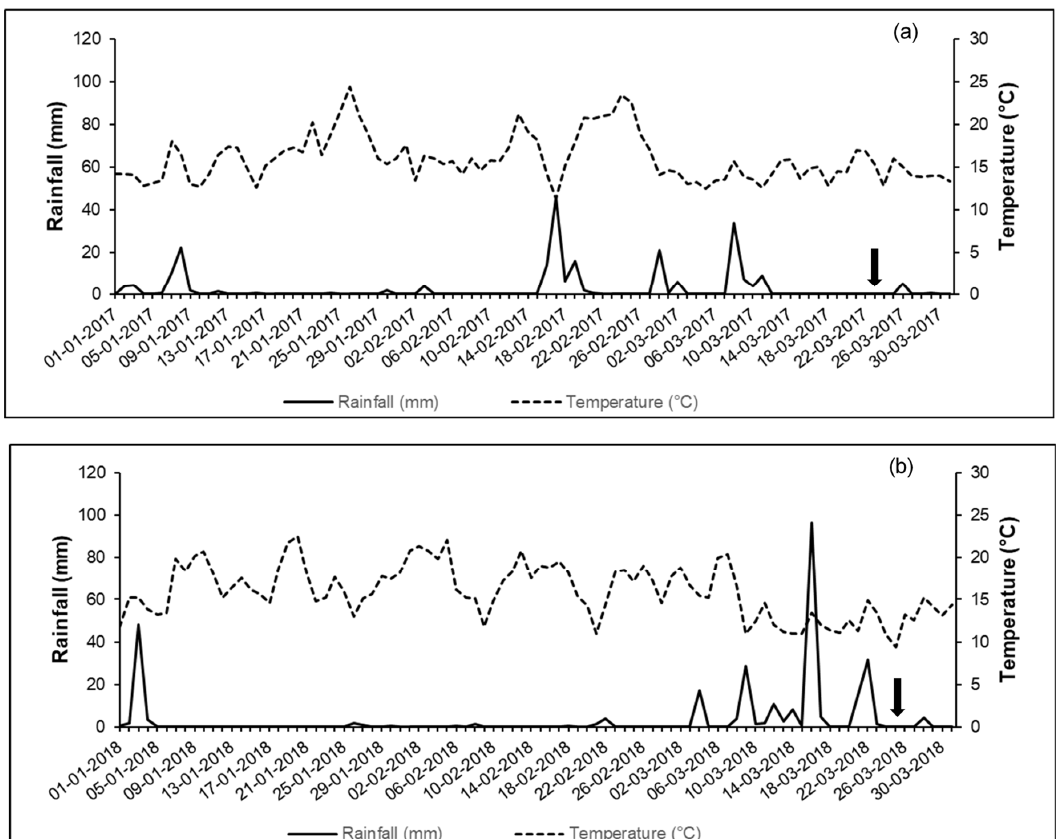
Figure 3. Rainfall (mm) and temperature (°C) in year 1 ( a ) and year 2 ( b ). The arrows indicate the day of application of the KBr solution.